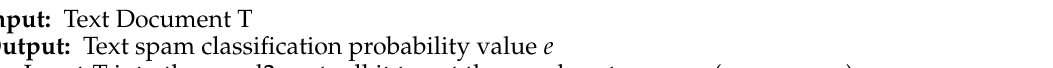
Algorithm 1 Text Spam Classification Algorithm.